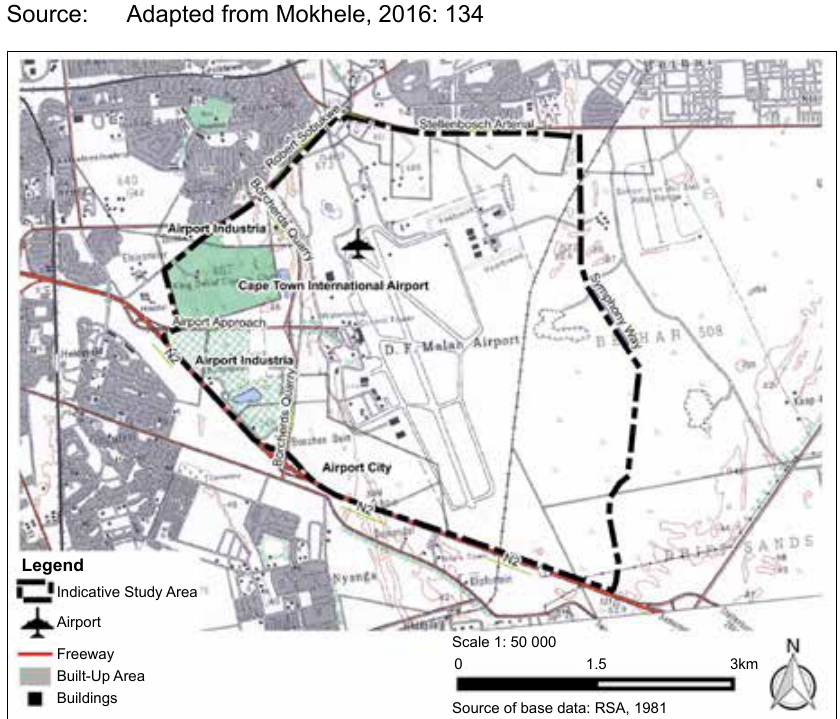
Figure 6: Cape Town International Airport and surrounds in